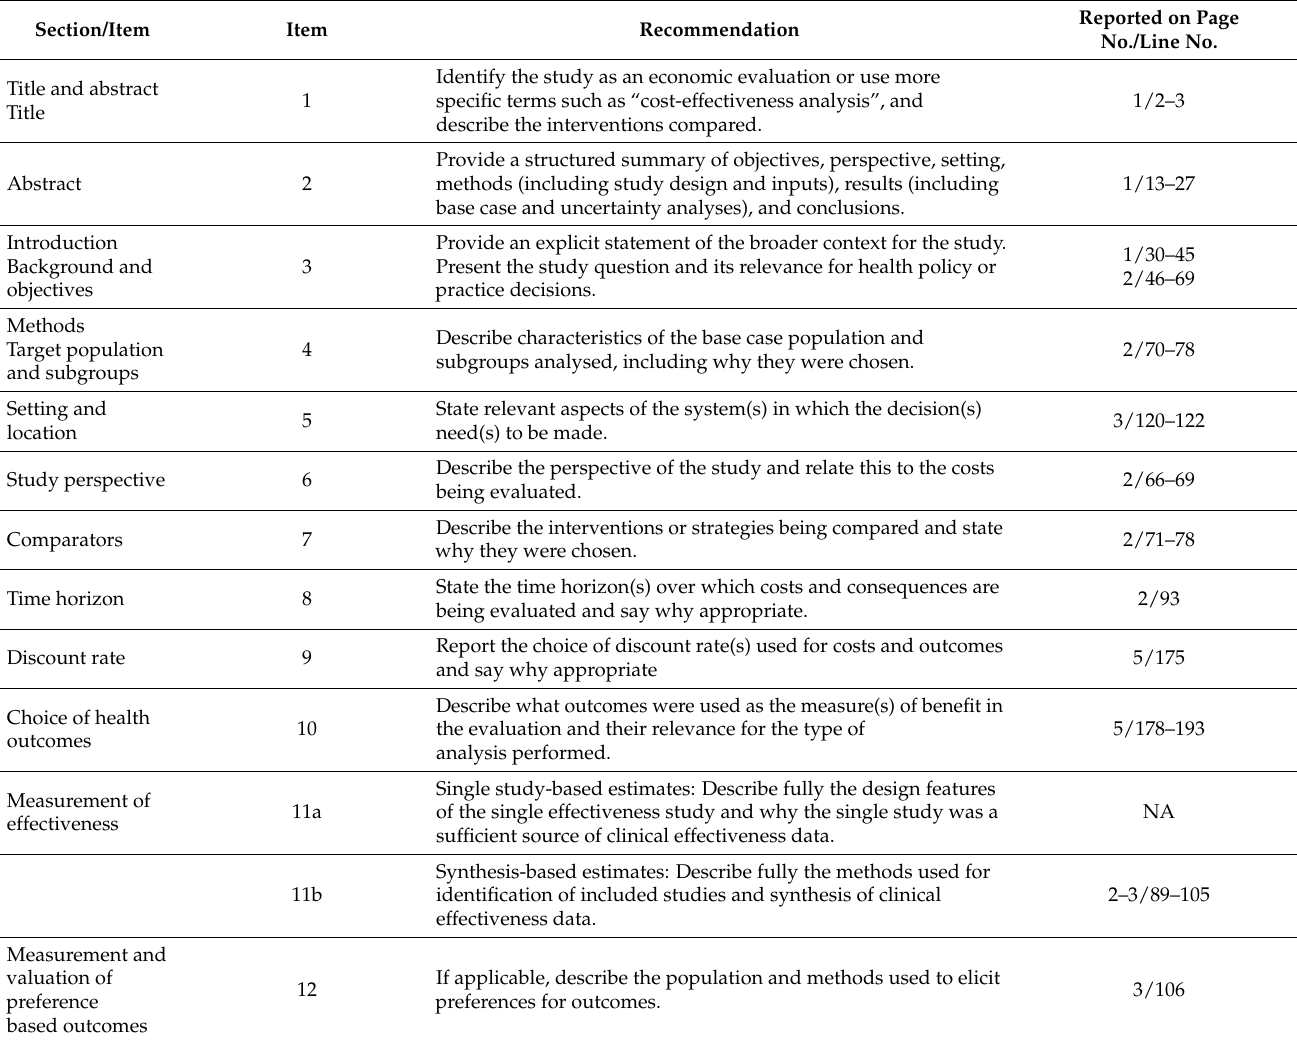
Table A5. Consolidated Health Economic Evaluation Reporting Standards (CHEERS) checklist of the present article based on ISPOR task report